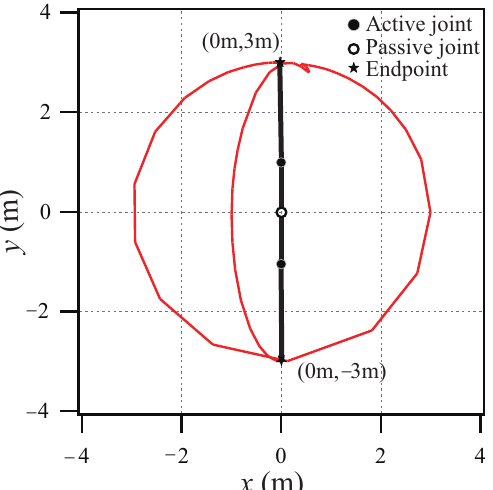
Figure 6. Endpoint